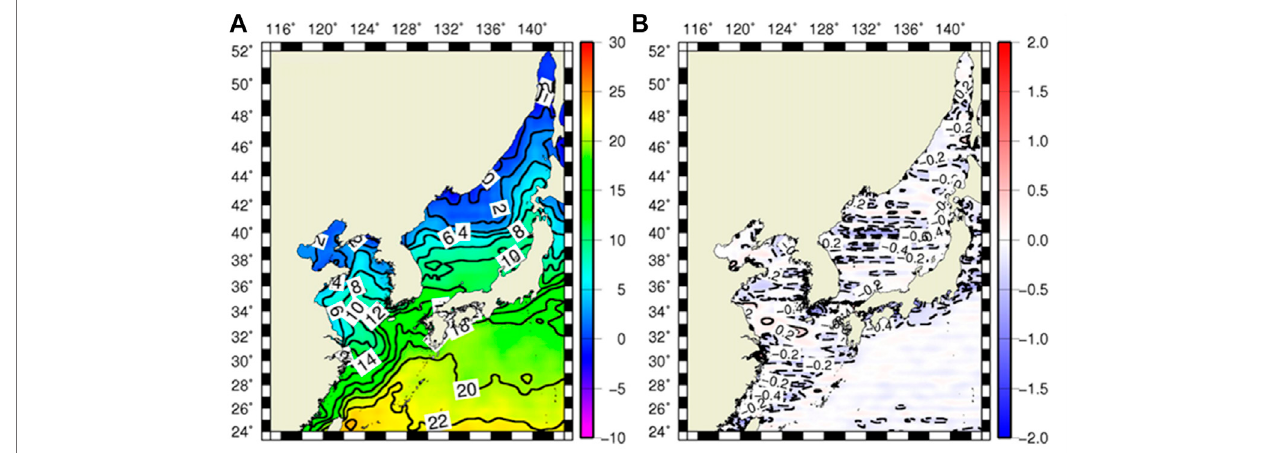
FIGURE 11 | The same as Figure 2 except for the entire East Asian marginal